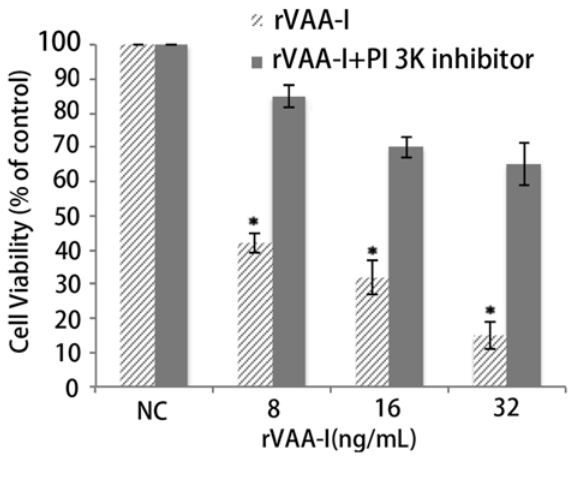
Figure 7. Effect of PI 3K cell signal pathway in SMMC-7721 cells treated with rVAA-I. SMMC-7721cells untreated or treated with 50 μ M PI 3K inhibitor (LY294002), and